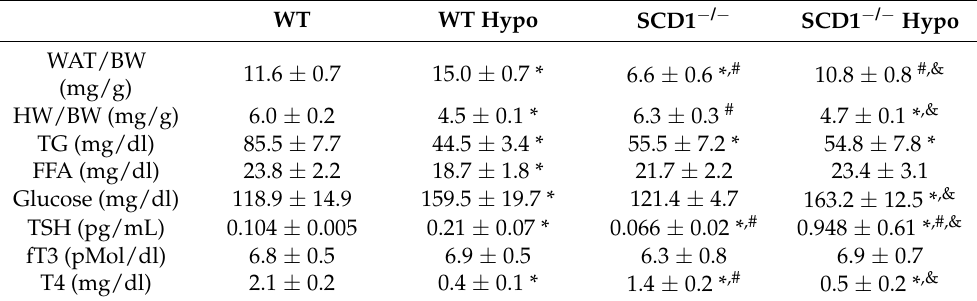
Table 1. Adiposity, heart weight, concentrations of plasma TG, FFA, glucose, TSH, fT3, and T4 in